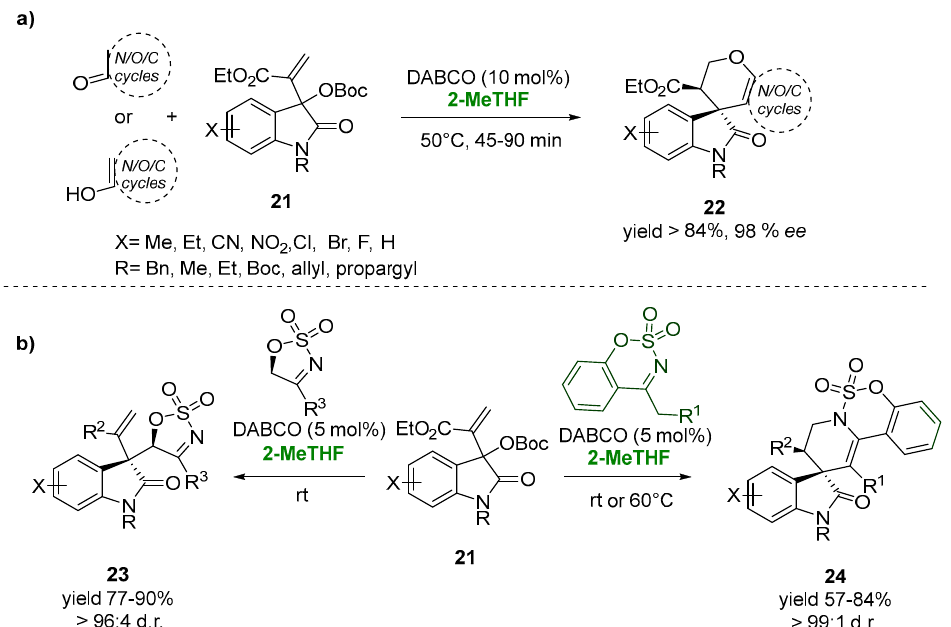
Figure 14. 3,3-disubstituted oxindoles via MBH-chemistry in 2-MeTHF ( a and b ).